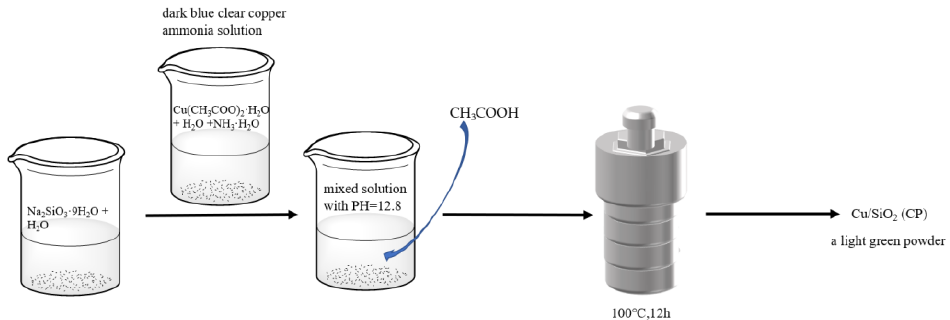
Figure 8. Preparation of Cu/SiO 2 (CP) by co-precipitation.